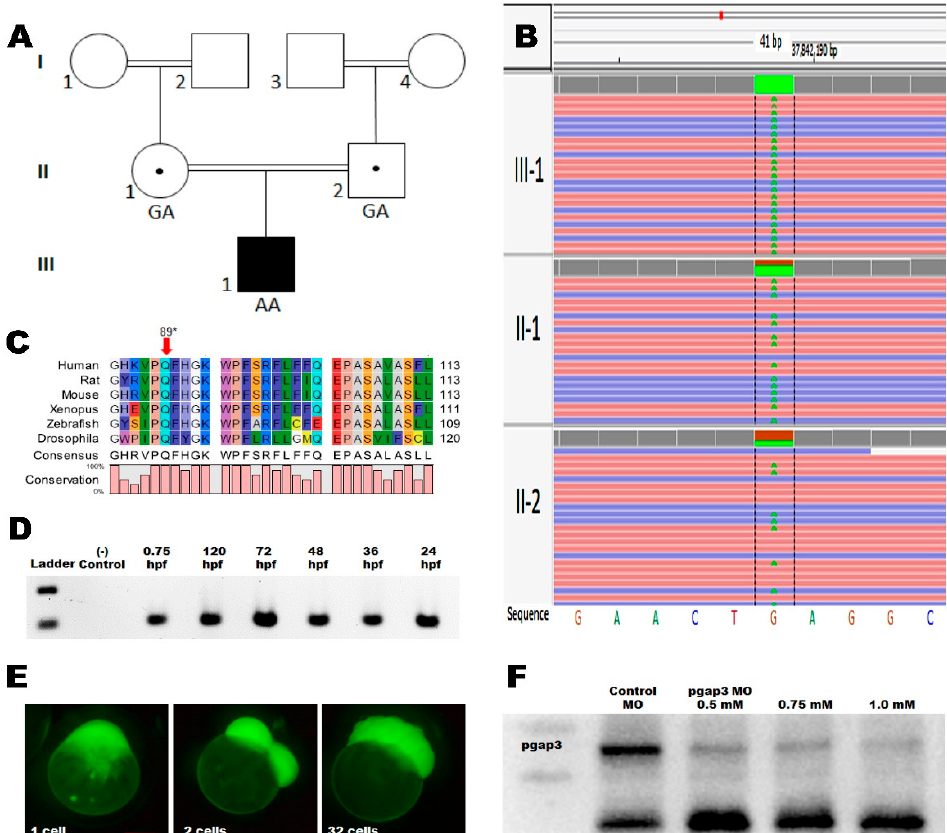
Figure 2. Molecular findings of the presented patient. ( A ) Pedigree of the studied family. ( B ) Sequencing gram showing PGAP3 mutation identified by whole-genome sequencing, c.265C > T-p. Gln89*. The grandparents from both sides are 1st-degree cousins. ( C ) Multiple species alignment of PGAP3 orthologs around the affected amino acid showing highly conserved p. Gln89 residue (red arrow). PGAP3 human (NP_001278659), rat (NP_001137367), mouse (NP_001028709), xenopus (NP_001072247), zebrafish (NP_001108063), and drosophila (NP_610223.1) using CLC Sequence Viewer, Qiagen Bioinformatics. ( D ) Gene expression at different developmental stages of zebrafish development by reverse transcriptase of total RNA. ( E ) Zebrafish morpholino-FITC injections were targeting the pgap3 ATG translation blocking site. The injected zebrafish embryo at 1-cell stage through cell divisions at two and 32-cell stage. Snap images using fluorescent imaging with Zeiss Lumar 12 microscope at 100 × magnification, scale bar 200 µ m. ( F ) Injected zebrafish total protein extracts analyzed by 10% SDS-PAGE, followed by immunoblot analysis using an anti-PGAP3 rabbit monoclonal antibody (1:300 dilution).